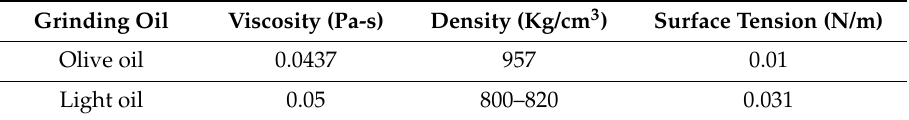
Table 4. Mechanical properties of grinding oils used in ire magnetic abrasive finishing.